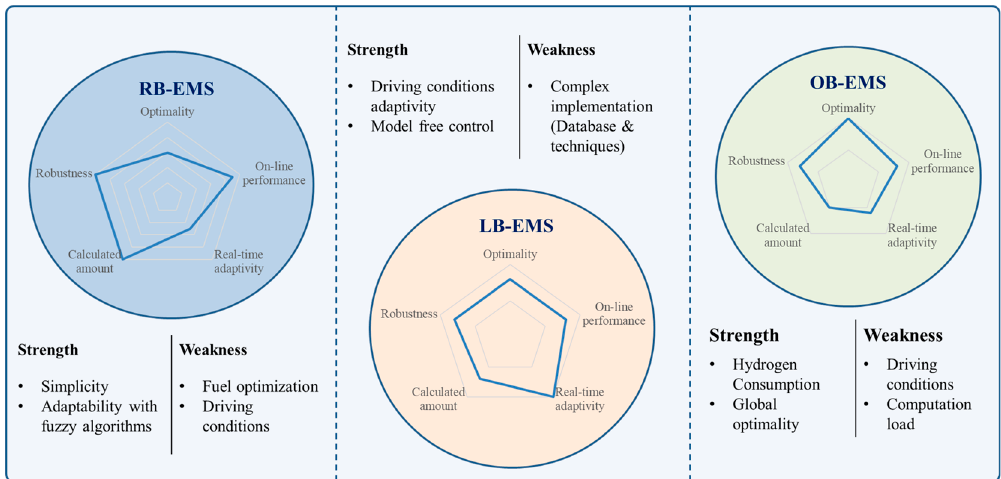
Figure 2. Strengths and limits of the classical EMS categories.